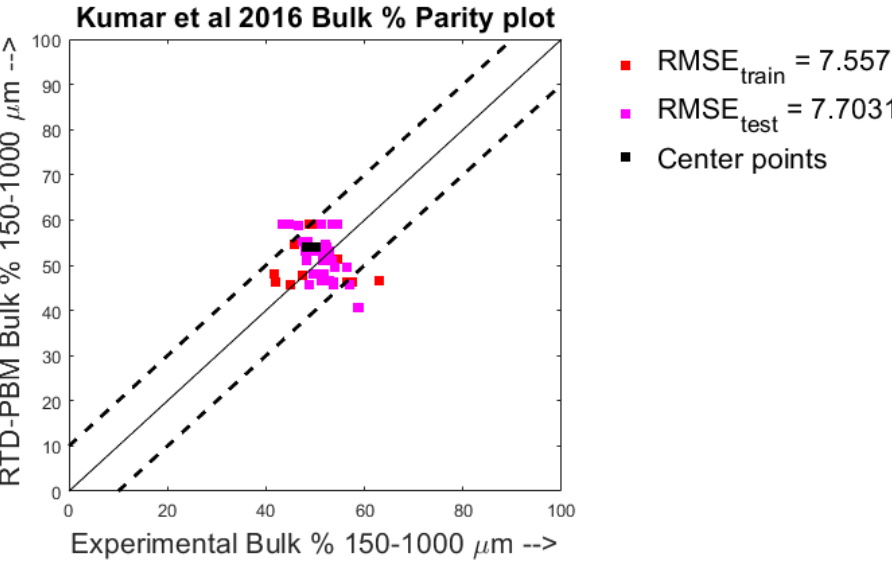
Figure 6. Experimental observations (X) vs. predicted model responses (Y) for outlet bulk granule sizes when the model is trained on the Kumar et al., 2016 [19] dataset.